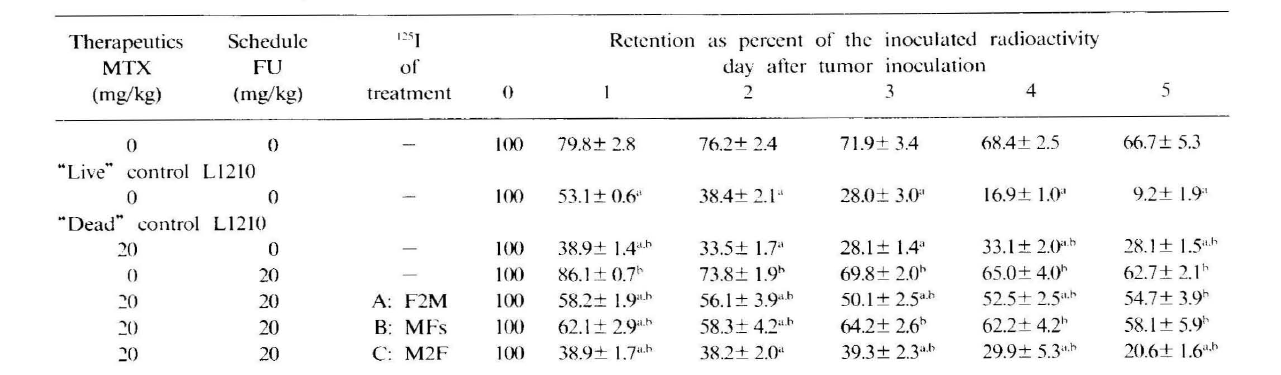
Table 2. Effect of MTX and FU scheduling on the loss of 12'1 activity from mIce inoculated i.p. with L1210 leukemio cells labelled with 12' I-iododeoxyuridine